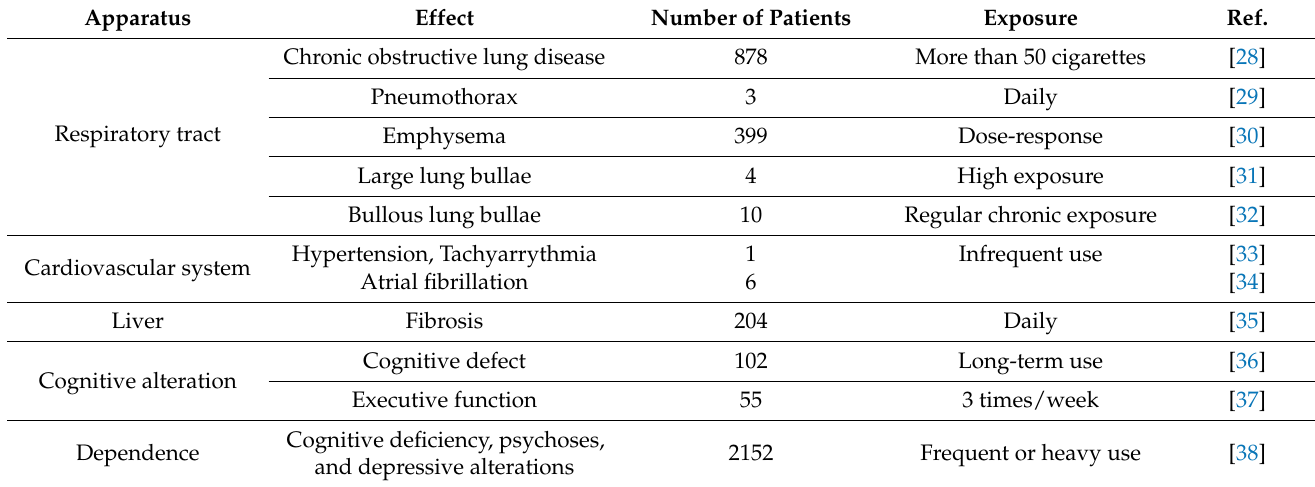
Table 1. Adverse effects of marijuana intake reported in clinical